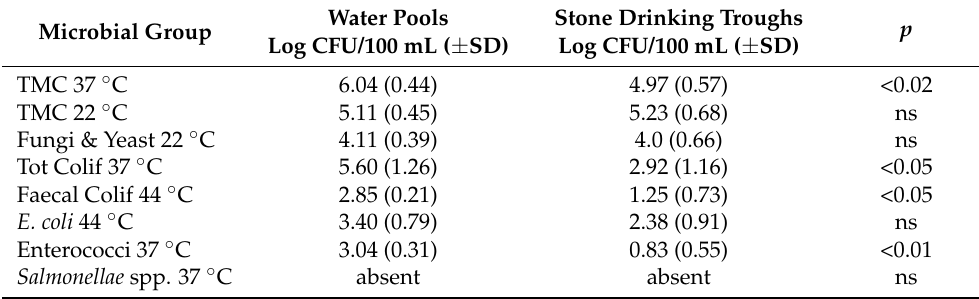
Table 3. Comparison of microbial count in water pools and stone drinking troughs samples. Results expressed as the mean of three replicates separately analyzed with ± SD. ns: not significant; p < 0.05 and p < 0.01 significant